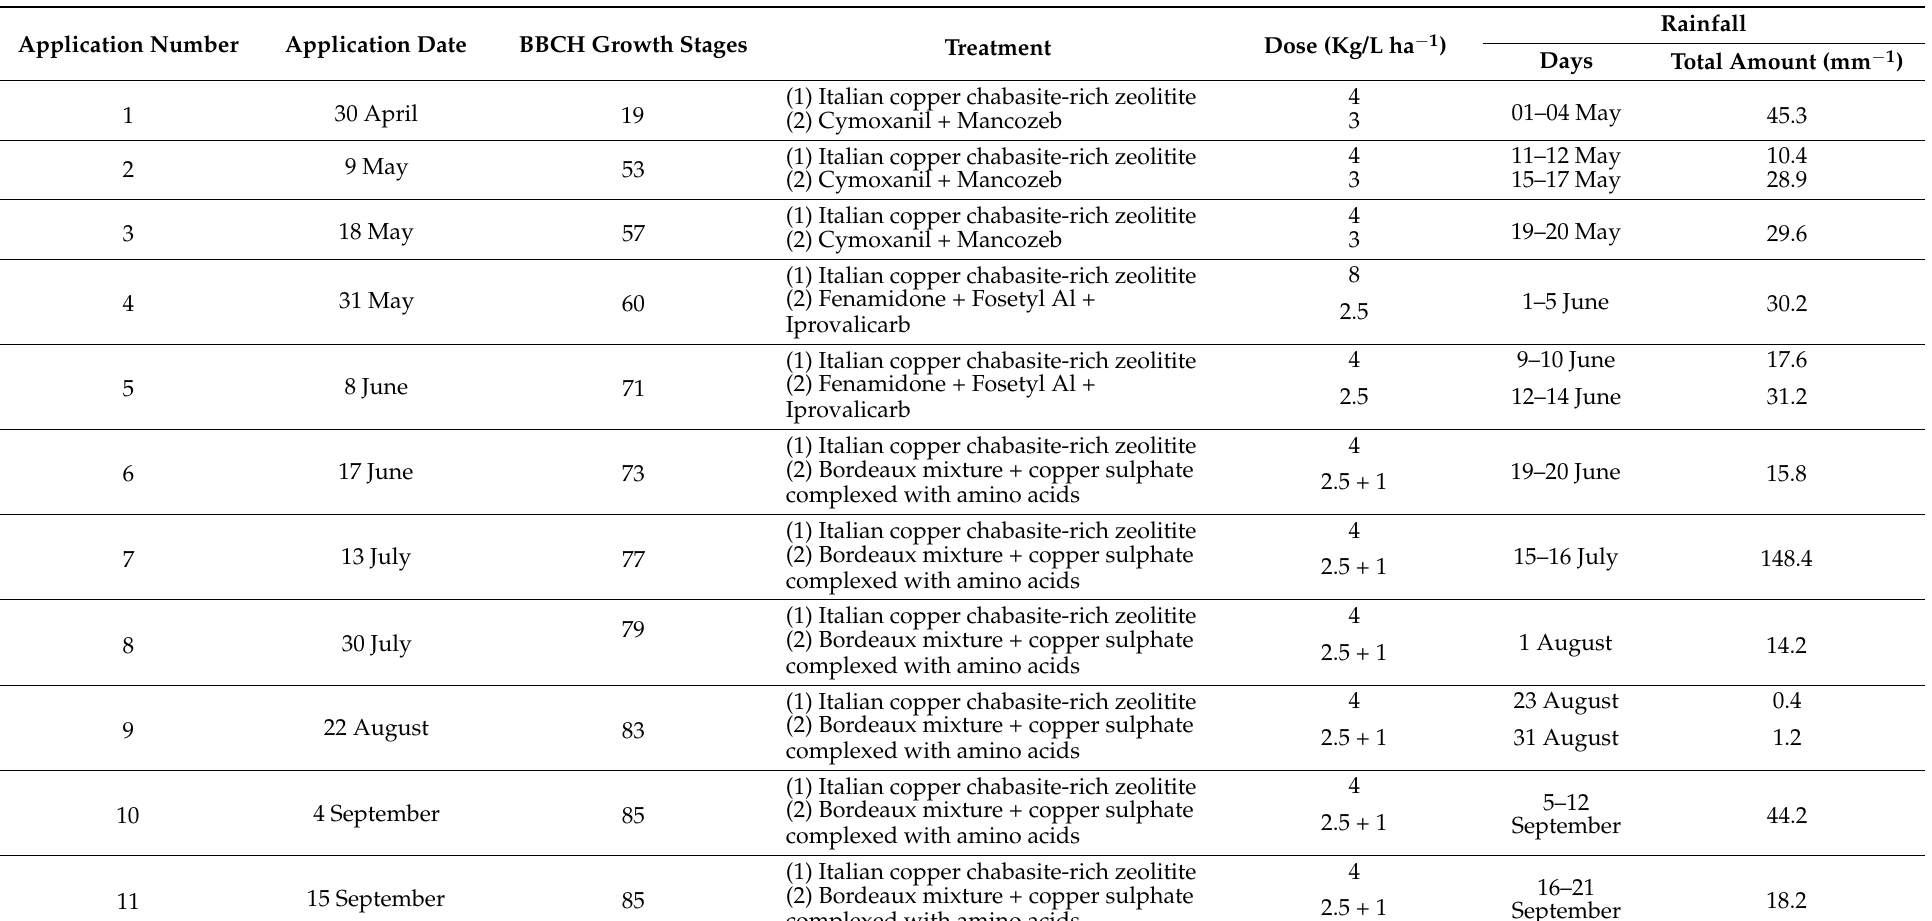
Table 2. Field application details targeted against grapevine downy mildew in cv. Montepulciano in the Ari vineyard in 2016 and rainfall amounts on the days after the